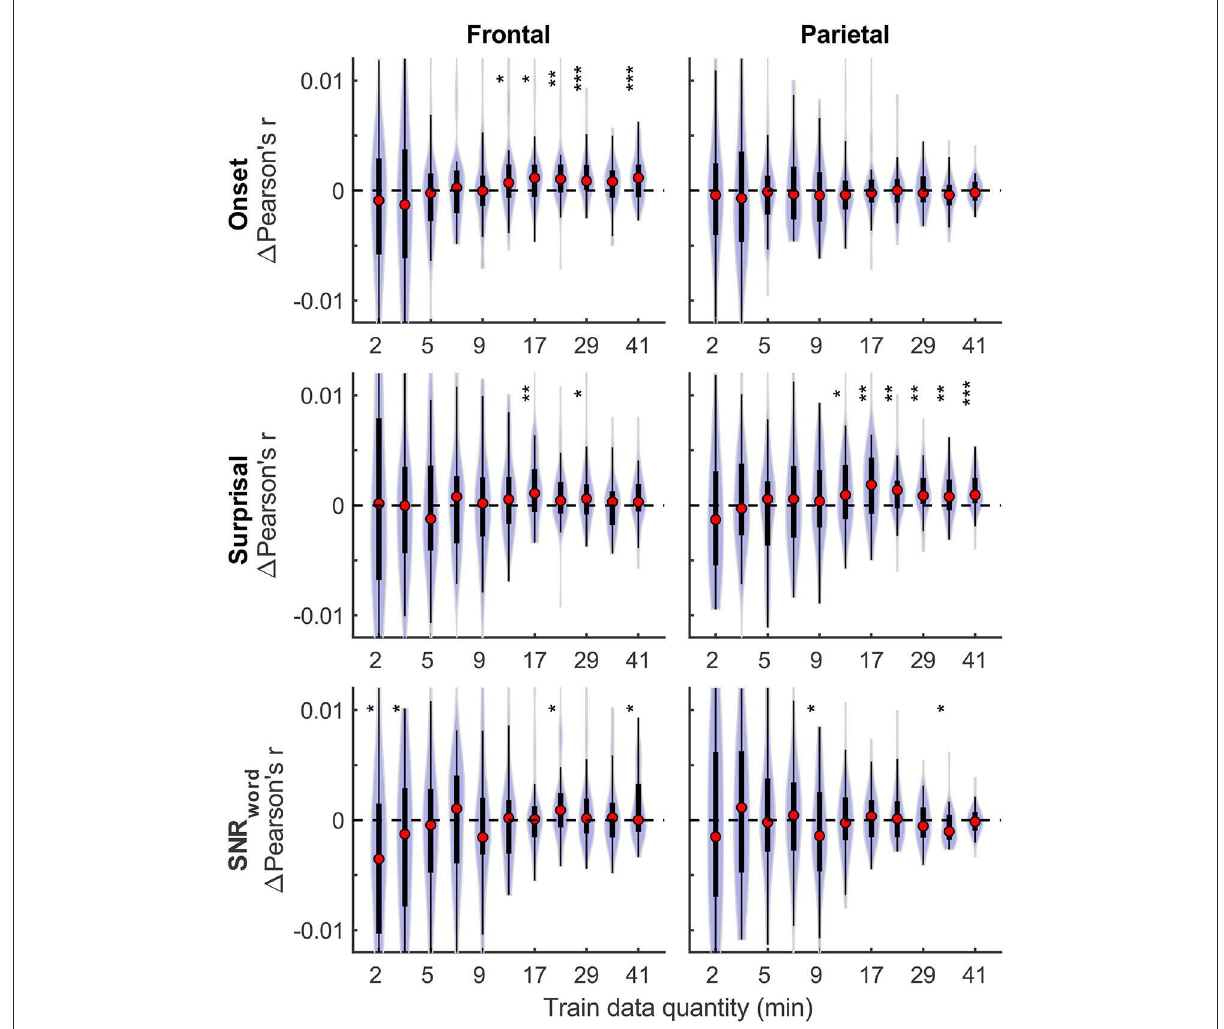
FIGURE3 Feature-specific model fit contributions as a function of training data quantity for the sparser model. The details of data visualization are as in Figure 2, and asterisks denote significance levels as in Figure